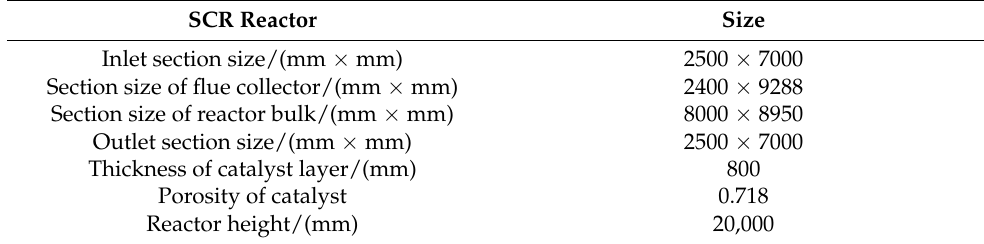
Figure 1. Geometric model of the SCR reactor. Table 1. Structural parameters of the SCR reactor.